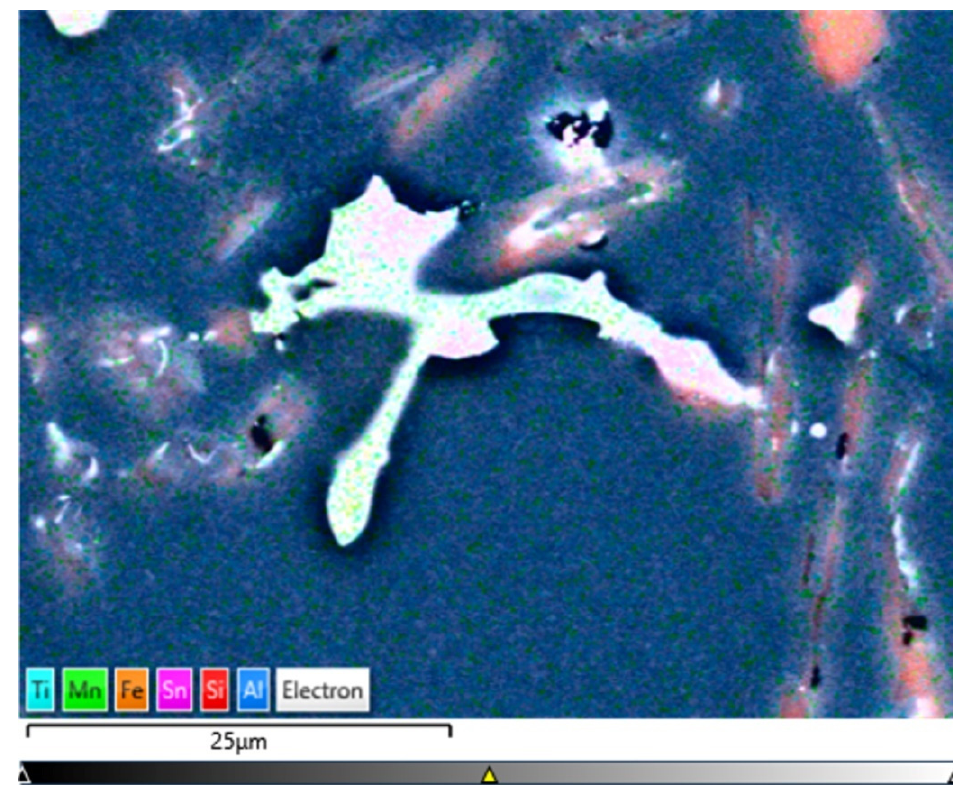
Figure 16. SEM-EDS layered image—AlSi10Sn1.7 alloy.